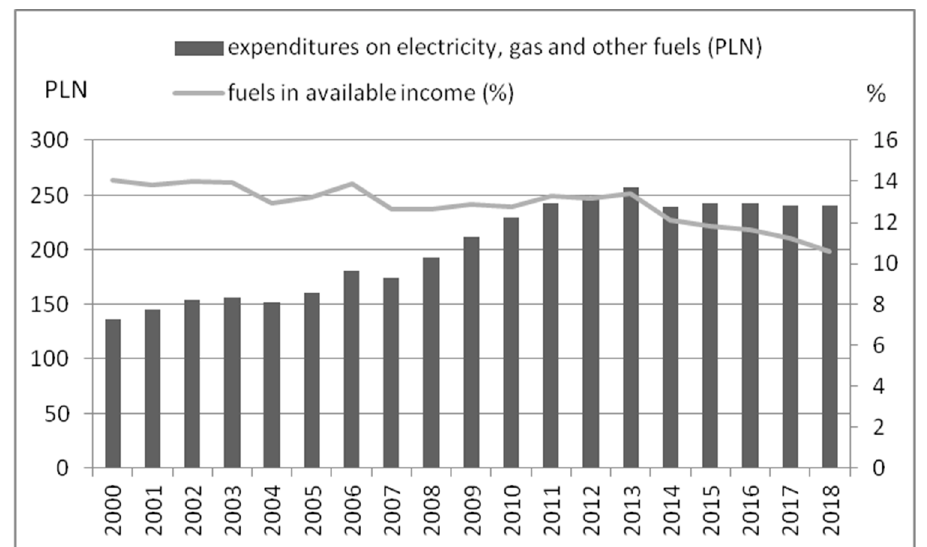
Figure 3. Expenditure on energy carriers and their share in available income in one-person households in the years 2000–2018. Comment: level of expenditures on energy carries: p = 0.000, the slope of a trend line = 7.1000, coefficient of determination R 2 = 0.8717; share of expenditures on energy carries in available income: p = 0.0000, the slope of a trend line = –0.1479, coefficient of determination R 2 = 0.7217. Source: own study and calculations based on CSO data.